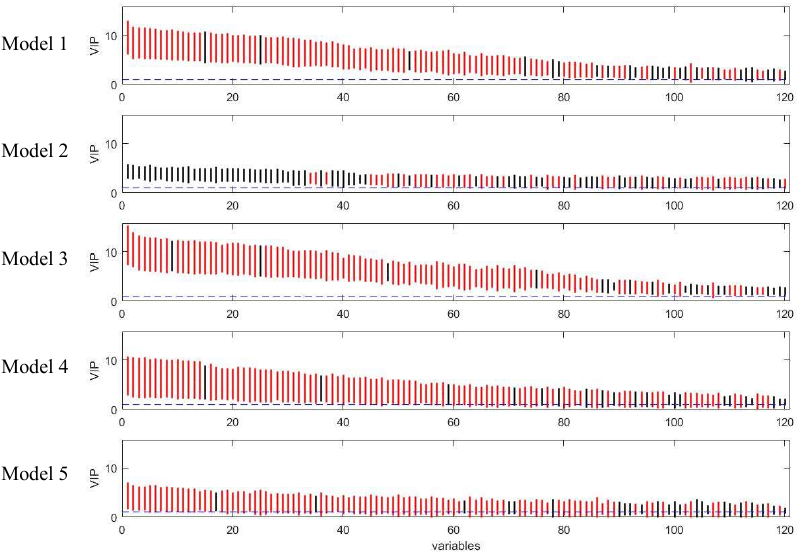
Figure 11. Rank of VIP scores for the discriminating variables in five PLS models on coffee study dataset. Bootstrapped VIP scores for all the variables were ranked according to their mean VIP scores in descending order. Red and black represent the variables which are discriminating or non-discriminating, respectively. The horizontal blue dash line corresponds to VIP = 1.